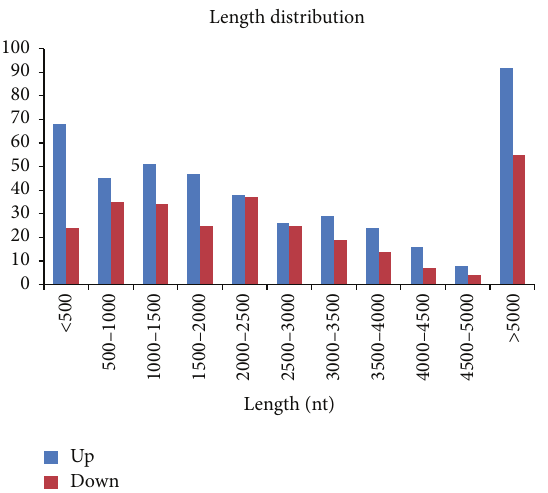
Figure 2: The length distribution of dysregulated lncRNAs. The lncRNAs were mainly less than 500 and longer than 5000 bp.